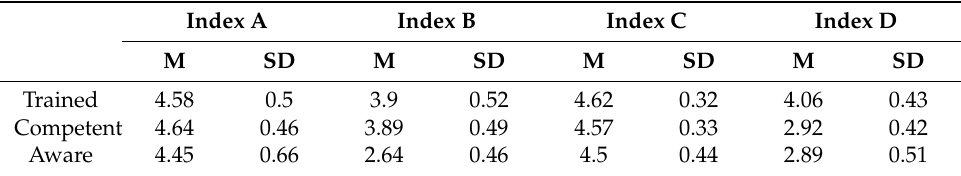
Table 5. Descriptive statistics of the indexes according to